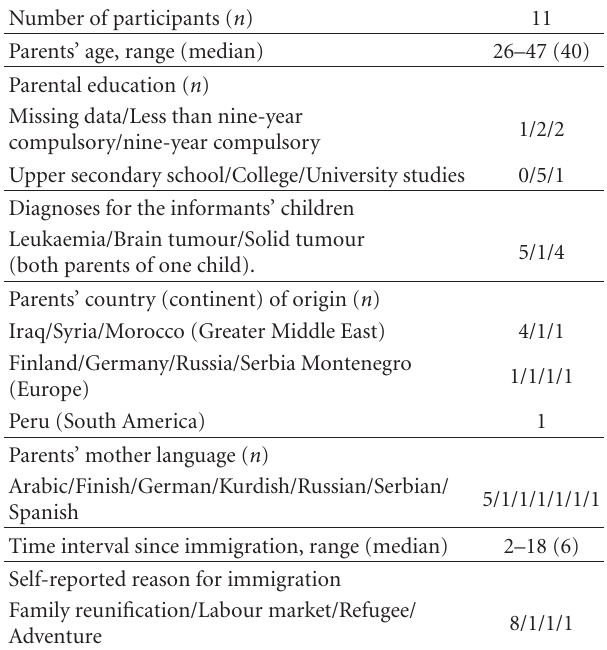
Table 1: Description of the